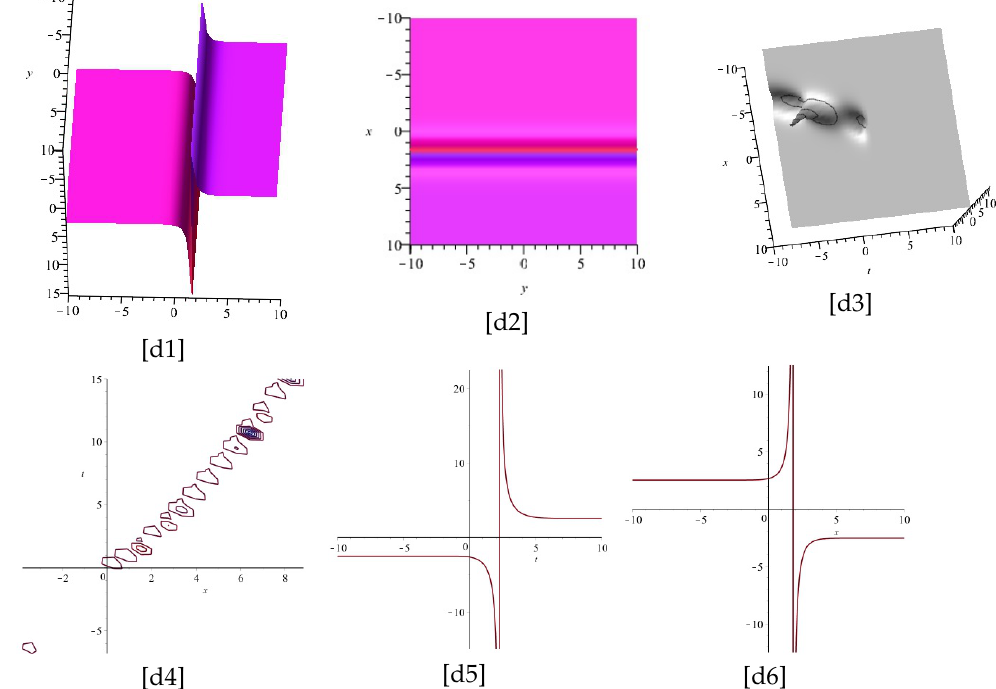
Figure 4. The plots of Equation (30), for λη < 0 and α = 0.75. Now, [d1] and [d3] are the imaginary and real parts of Equation (30), and [d2], [d4], [d5], and [d6] display the z -axis orientation, the contour plot, the 2d for x = 2, and the 2d for t = 2, of the imaginary part of [d1],